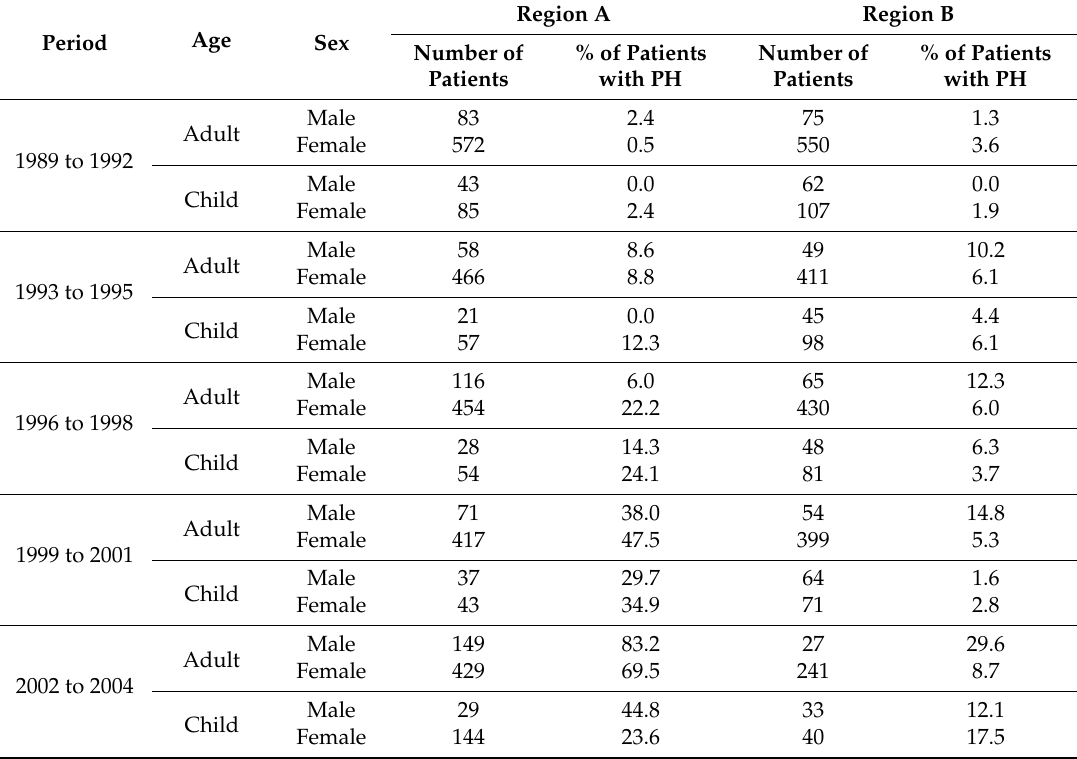
Region A Region B Region A Region B Number of with PH with PH with PH with PH